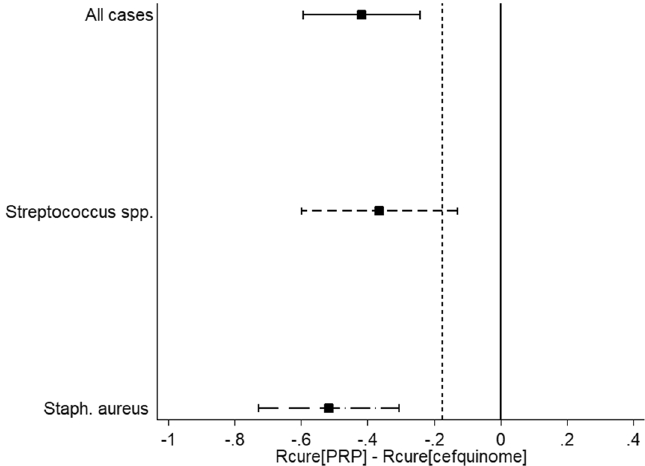
Figure 5. Graphical representation of the risk difference for bacteriological cure between 10 mL of P-PRP (pure platelet rich plasma) and 75 mg of CS (cefquinome sulfate) over three consecutive milkings. The black dotted vertical line represents the non-inferiority margin ( Δ ), and the area to the right of this value (− 0.175) indicates the zone of non-inferiority. The solid square is the point-estimate of difference in cure between P-PRP and CS; caps of the horizontal lines indicate 95% CI. All cases = bacteriological cure of all cases, the CI does not span both zero and the non-inferiority margin (− Δ ), which indicates that CS is significantly better. Streptococcus spp. (includes only Streptococcus uberis , Streptococcus agalactiae and Streptococcus dysgalactiae ) = bacteriological cure in Streptococcus spp. cases: the CI spans − Δ but not 0, implying that CS is better, however, non-inferiority is inconclusive. Staph. aureus = bacteriological cure in Staphylococcus aureus cases: the CI does not span both − Δ and zero, thus CS is significantly